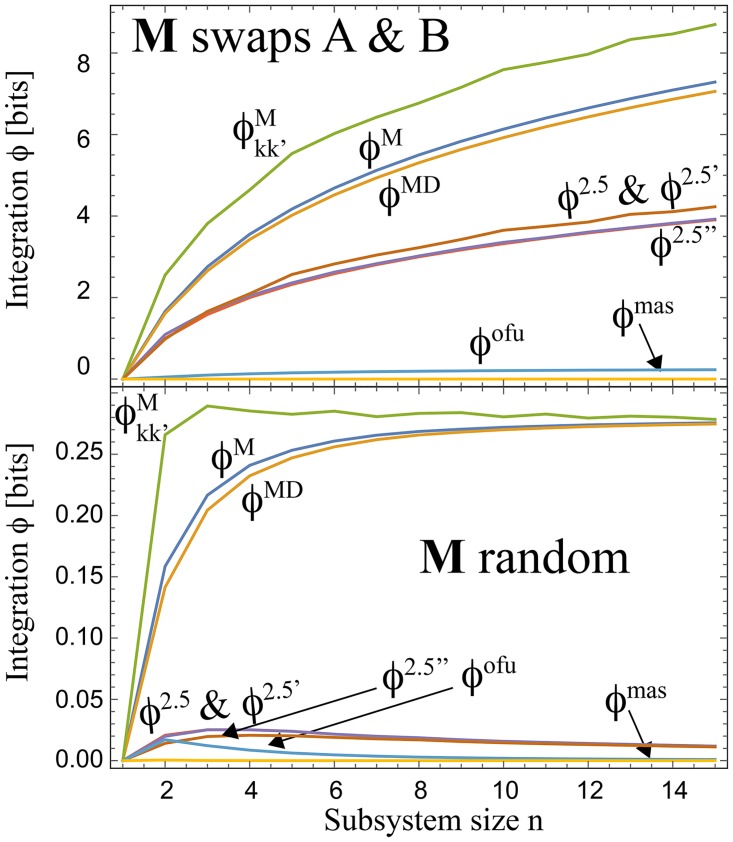
Numerical comparison of different integration measures, averaged over 3,000 random trials.In the bottom panel, all elements of p are independently drawn from a uniform distribution and normalized to sum to unity. In the top panel, only p(0) is randomly generated, and M is defined so as to swap the two subsystems, i.e., Mjj′ii′ = δij′
δi′j.